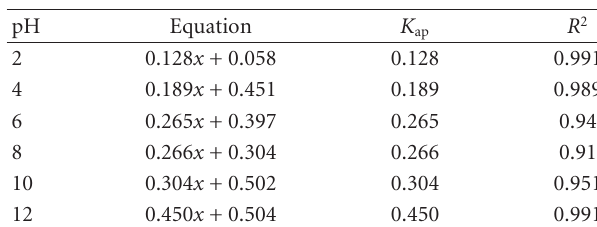
Table 3: E ff ect of pH on photocatalytic degradation of aniline under UV illumination in HCBR (experimental conditions: initial aniline: 50 mg/L; catalyst concentration: 60mg/L; temperature: 293